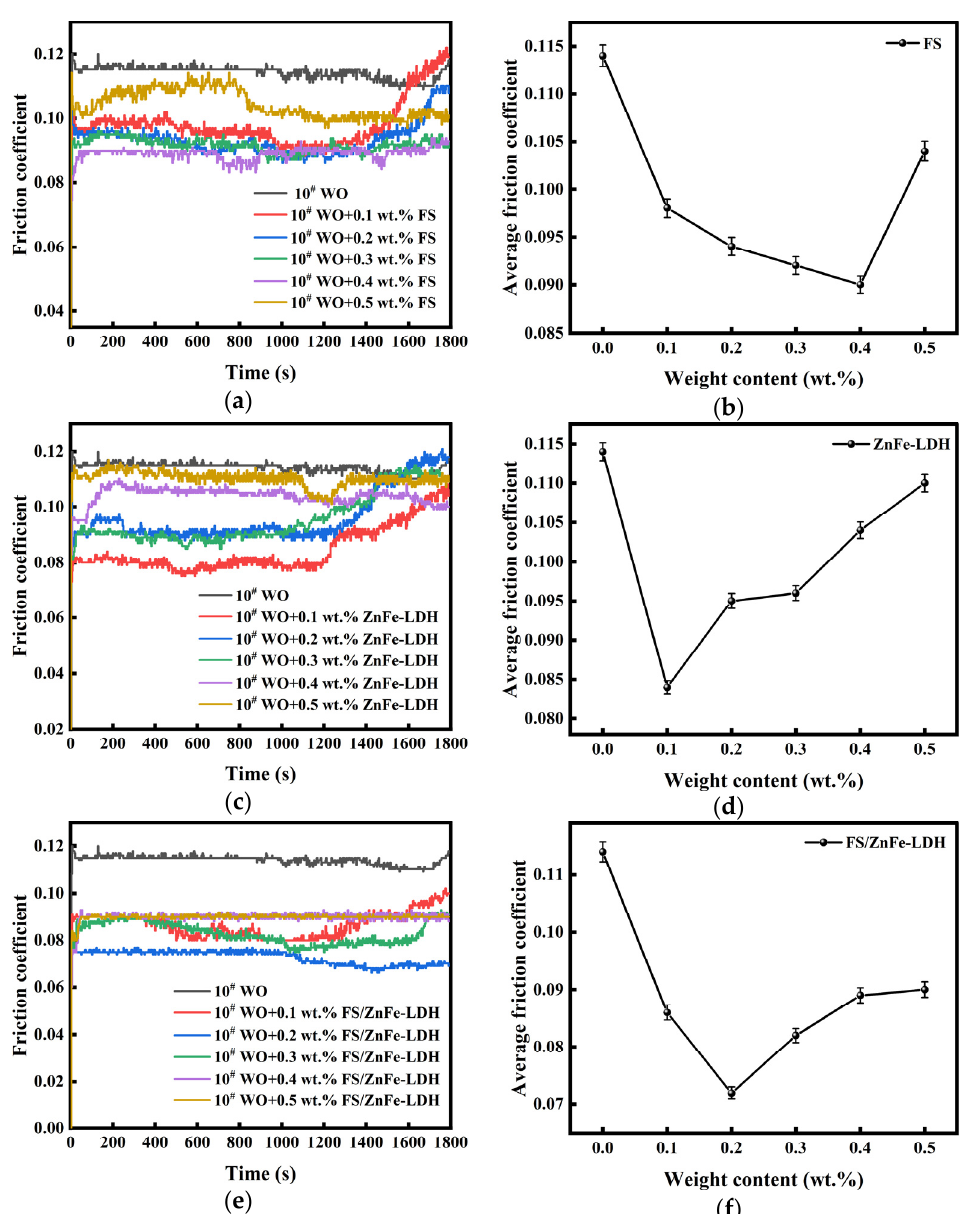
Figure 6. Friction coefficient and average friction coefficient diagram of ZnFe-LDH, FS/ZnFe-LDH, and FS. ( a , b ) FS; ( c , d ) ZnFe-LDH; ( e , f ) FS/ZnFe-LDH.